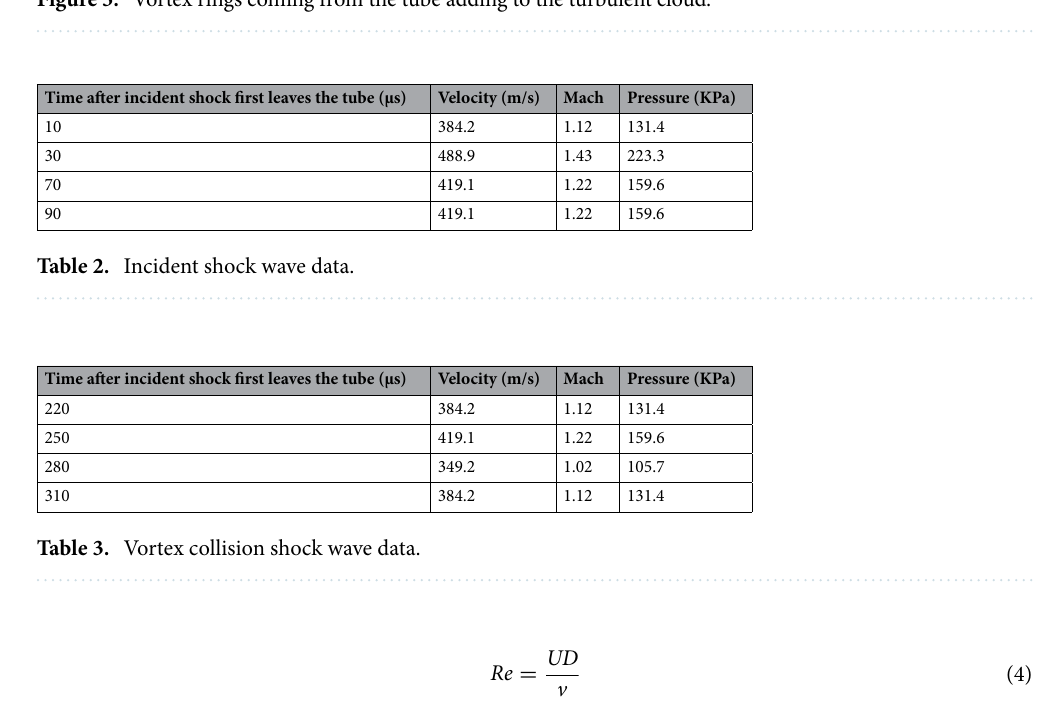
Figure 5. Vortex rings coming from the tube adding to the turbulent cloud.